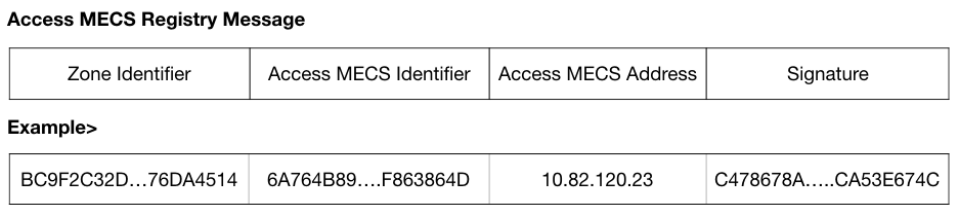
Figure 2. AMR message format and